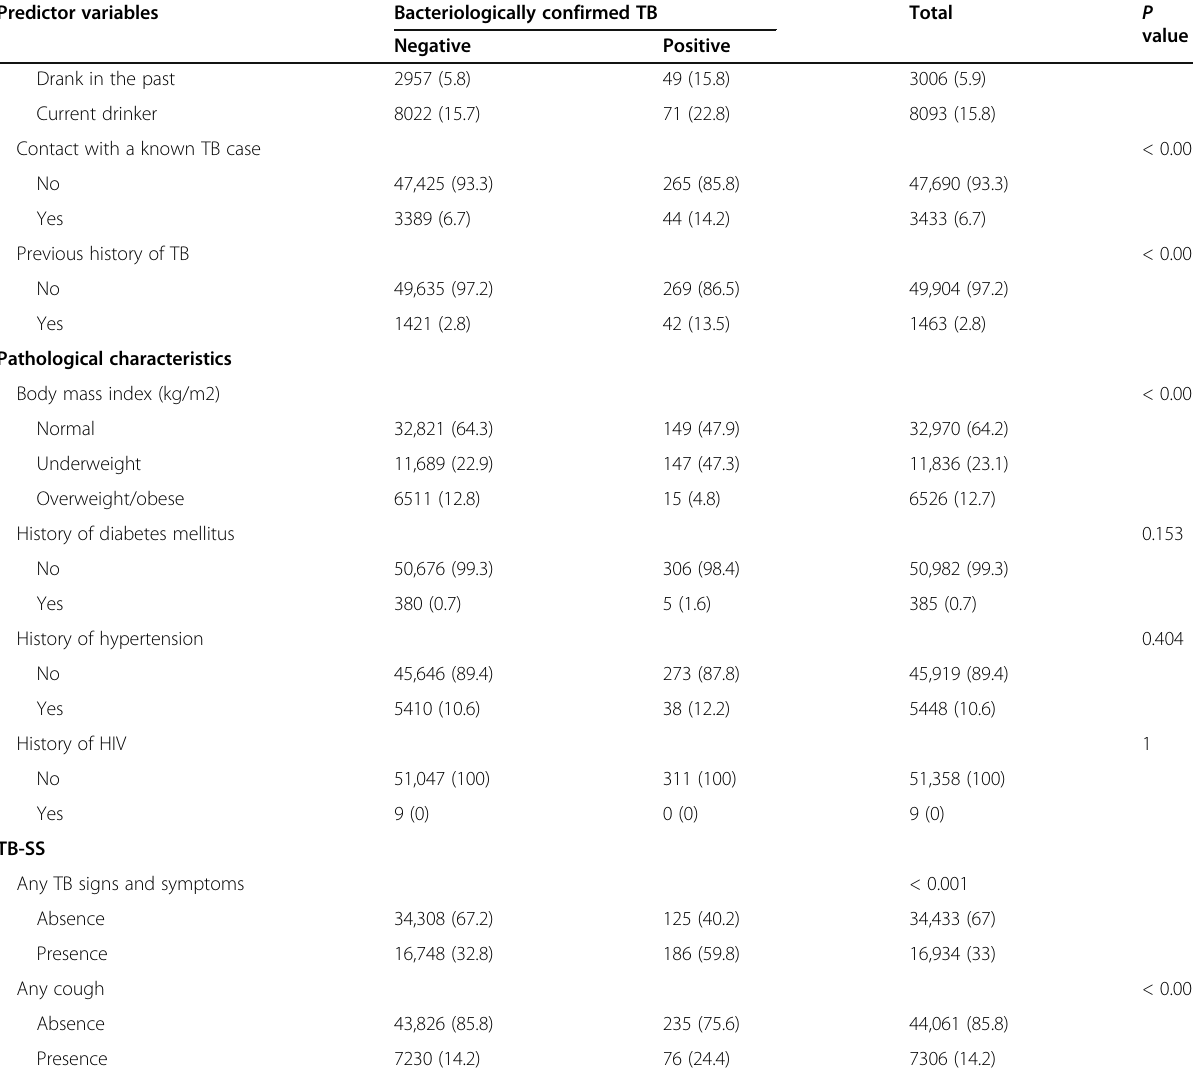
Table 3 Predictor variables associated with bacteriologically confirmed TB in univariate analysis (Continued) Predictor